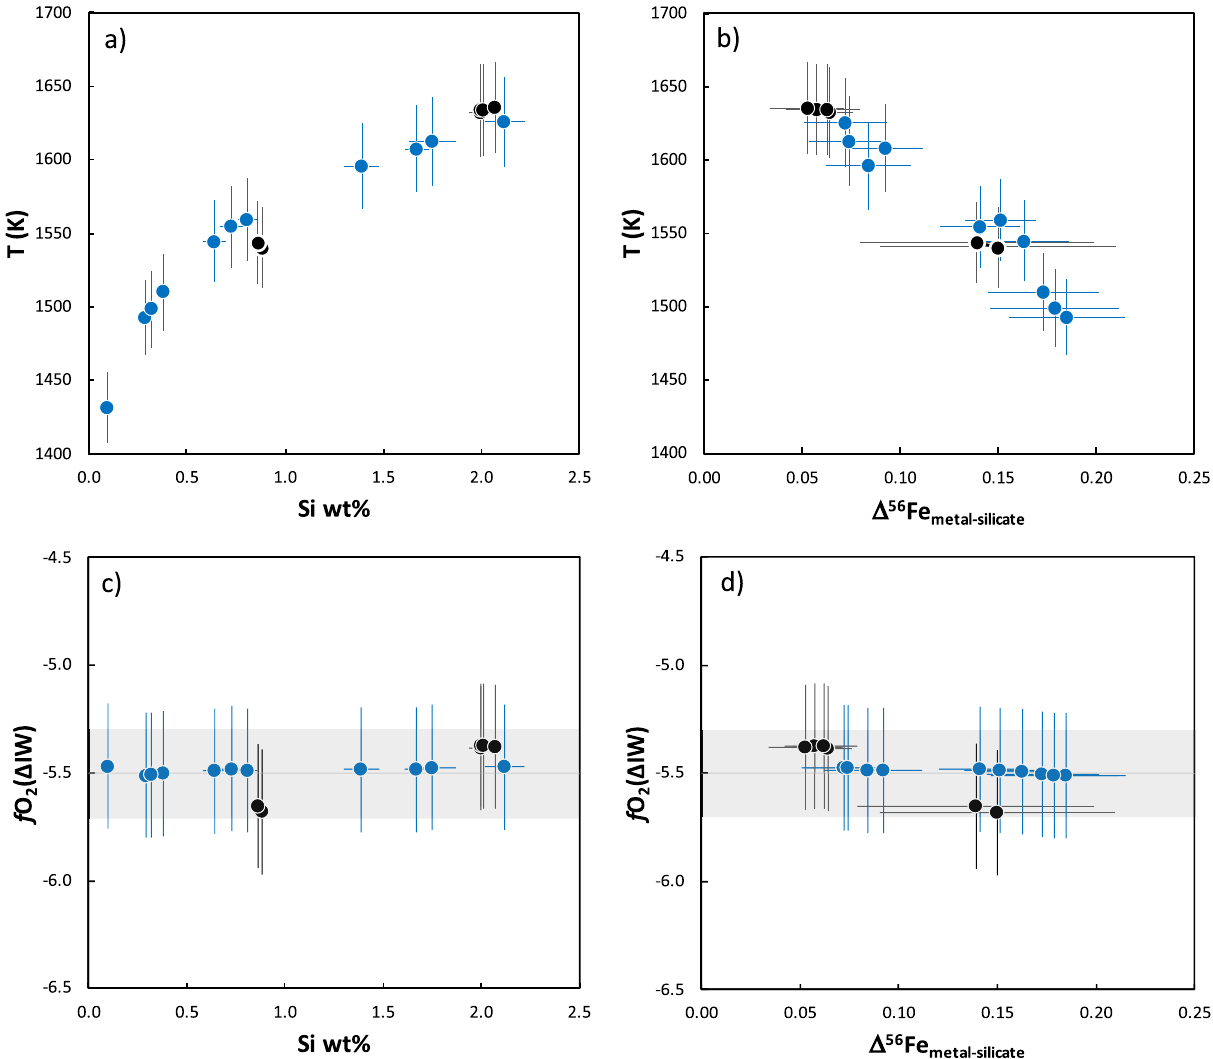
Figure 2. Plots of ( a ) calculated metal-silicate equilibration temperature (T in Kelvin) vs. measured Si content (wt%); ( b ) calculated metal-silicate equilibration temperature (T in Kelvin) vs. Δ 56 Fe metal-silicate ; ( c ) calculated f O 2 (� I W ) vs. Si content (wt%); and ( d ) calculated f O (� I W ) vs. Δ 56 Fe 2 metal-silicate for aubrite metals. The horizontal grey line and box in 2c and 2d represent the average ± 2SD (i.e.,–5.5 ± 0.2) of the calculated f O 2 for the aubrite metals. The Δ 56 Fe metal-silicate (δ 56 Fe metal –δ 56 Fe silicate ) values are calculated using δ 56 Fe metal from this study and δ 56